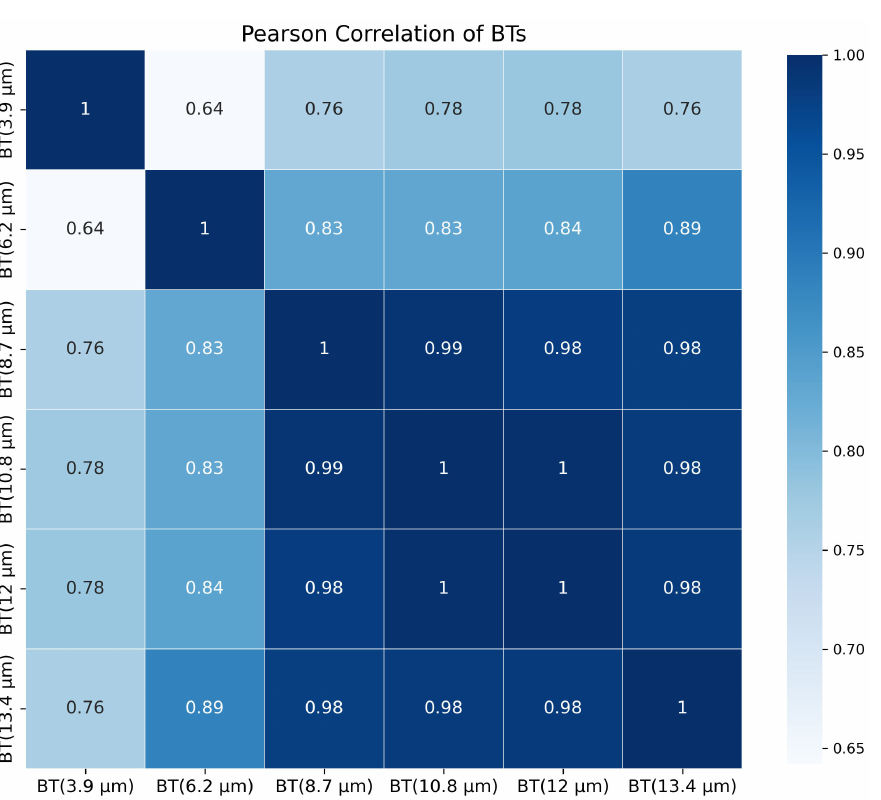
Figure 7. Heat map of correlations among brightness temperature (BT) data.